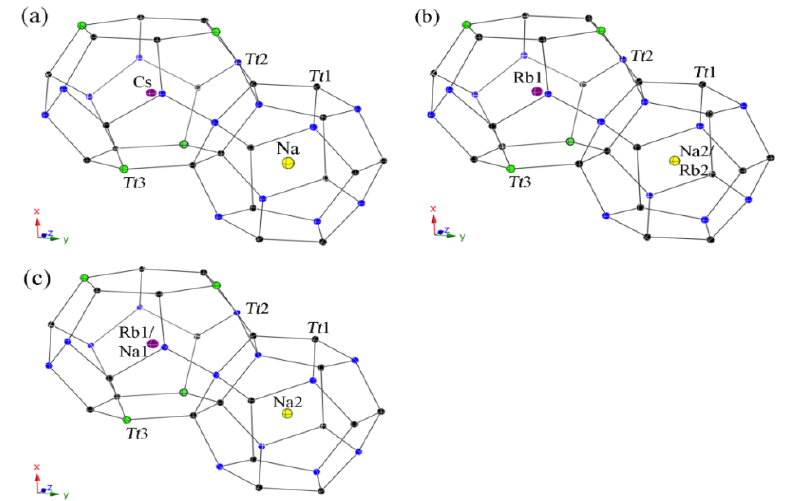
Na Ga Si ; 6 2 8.25 37.75(3)